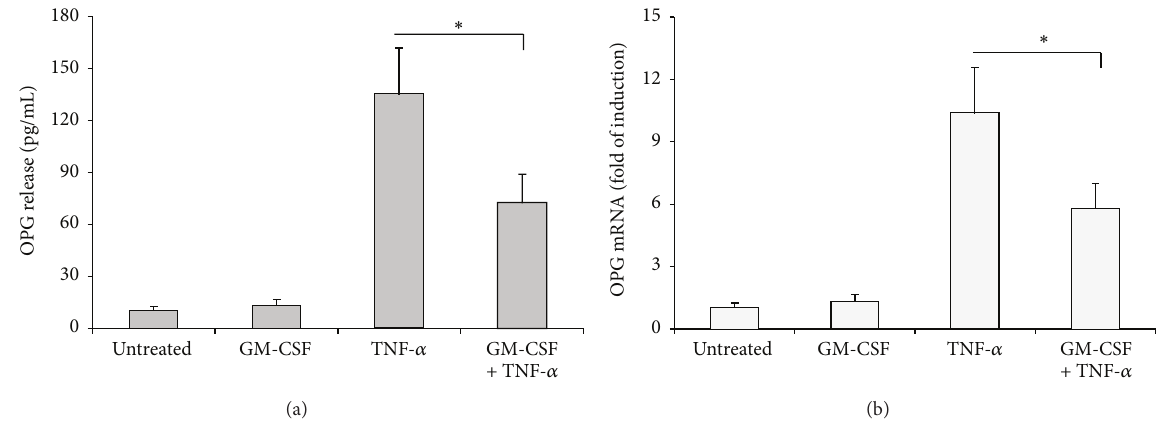
Figure 4: GM-CSF treatment downmodulates the TNF- 𝛼 induced expression of the proinflammatory marker OPG. VEC were left untreated or pretreated for 1 hour with GM-CSF (20ng/mL) before addition of TNF- 𝛼 (5ng/mL). OPG expression was analyzed after 24 hours of TNF- 𝛼 stimulation. In (a), the release of OPG in supernatants of VEC cultures treated as indicated was analyzed by ELISA. Results are expressed as means + SD of result from 4 independent VEC cultures. ∗ 𝑃 < 0.05 . In (b), the expression levels of OPG in VEC cultures treated as indicated were determined by quantitative RT-PCR. Results from amplifications, done in duplicate, are expressed as fold of untreated cells (set to 1), after normalization for the housekeeping gene. ∗ 𝑃 < 0.05